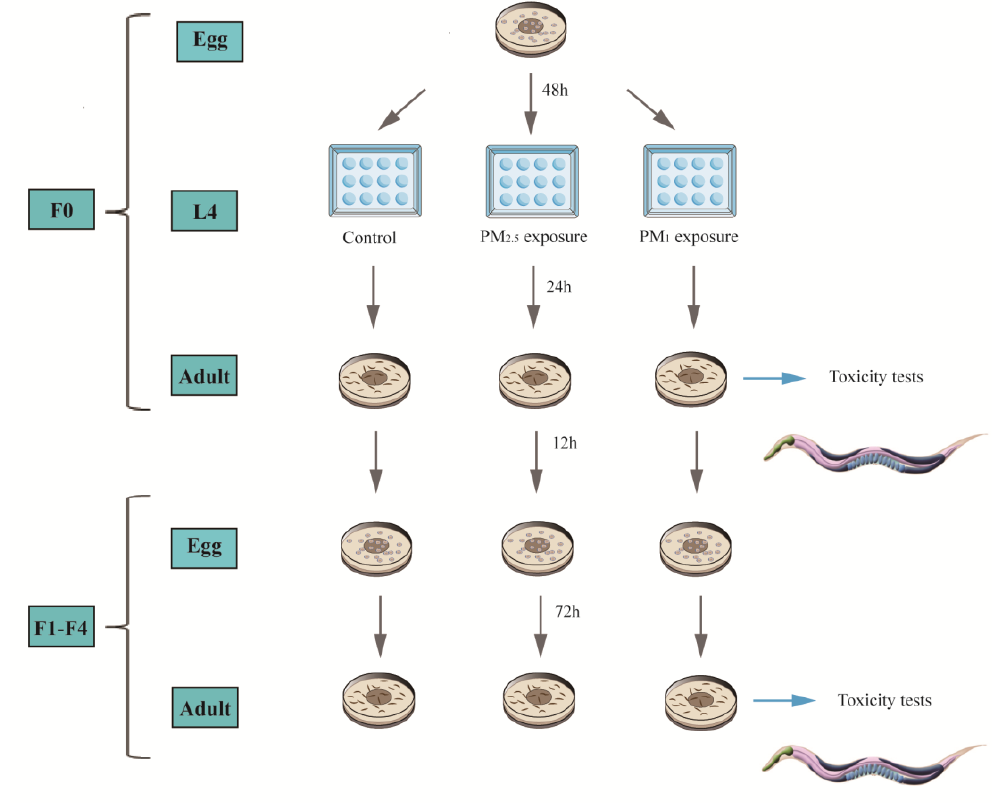
Figure 1. Schematic diagram of the acute exposure experiment using C. elegans .